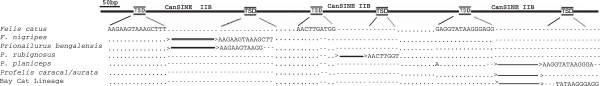
CanSINE insertions at locus 212075. Arrangement of six unique insertion events occurring at locus 212075 in the Asian Leopard Cat lineage species of rusty spotted cat (P. rubiginosus), flat-headed cat (P. planiceps), Asian leopard cat (P. bengalensis), and black-footed cat (F. nigripes) along with synapomorphies of the African golden cat clade (P. caracal/aurata), and the Bay Cat lineage. The insertions in the Asian Leopard Cat lineage species (P. bengalensis N = 9) and flat-headed cat (P. planiceps N = 5) are unfixed.